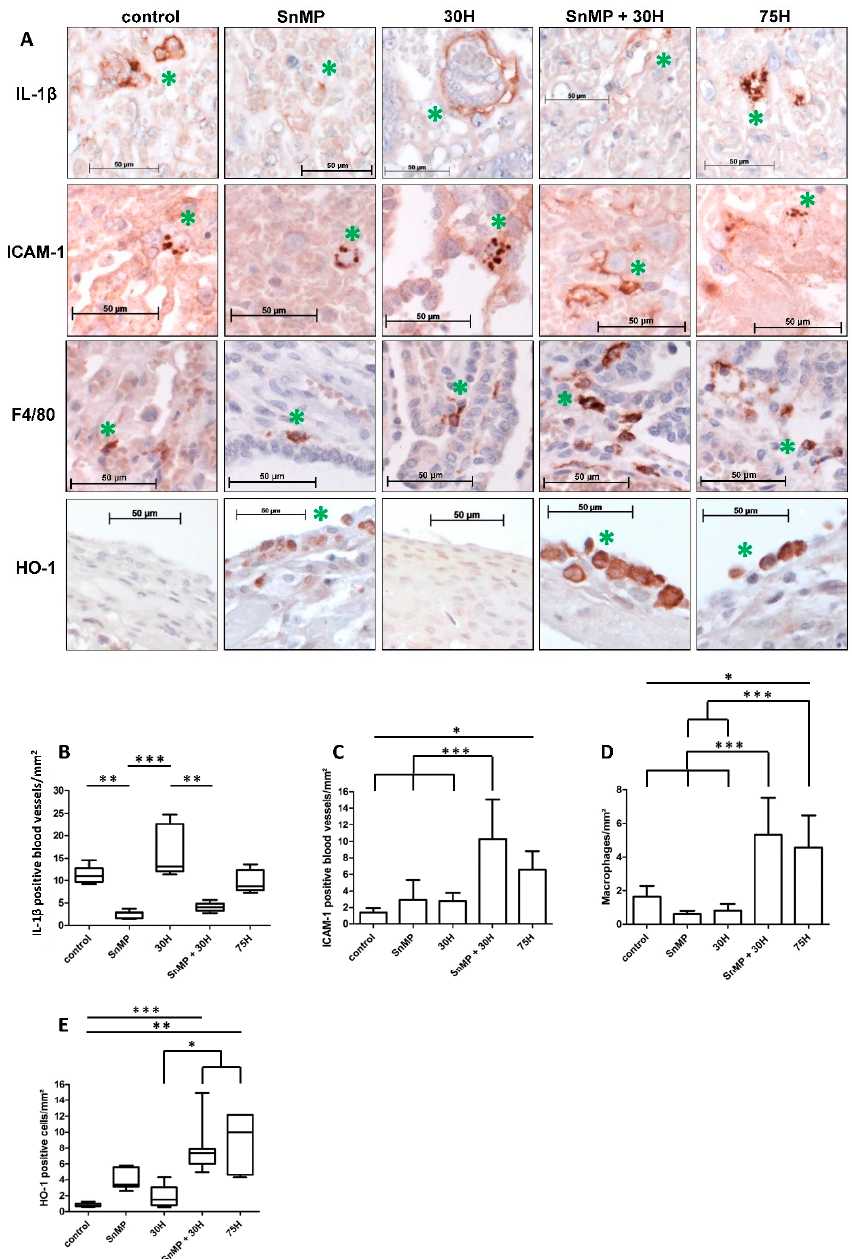
Figure 4. Quantification of IL-1 β , ICAM-1, F4/80 and HO-1 immunoreactivity in placenta. ( A ) Placental sections stained for immunoreactivity of IL-1 β , ICAM-1, F4/80 and HO-1. Representative IL-1 β , ICAM-1, F4/80 and HO-1 immunostaining in placenta from the control and experimental groups. Green asterisk indicates IL-1 β positive blood vessel, ICAM-1 positive blood vessel, F4/80 positive macrophage and HO-1 positive cell, respectively. ( B ) Box-and-whisker plot with 10–90 percentiles of quantitative assessment of the IL-1 β positive blood vessels/mm 2 compared for the different heme and/or SnMP administrations. ( C ) Bar chart of ICAM-1 positive blood vessels/mm 2 compared for the different heme and/or SnMP administrations. Data are shown as mean ± SD. ( D ) Bar chart of number of macrophages/mm 2 compared for the different heme and/or SnMP administrations (control n = 6; SnMP n = 7; 30H n = 6; SnMP + 30H n = 7; 75H n = 5). Data are shown as mean ± SD. ( E ) Box-and-whisker plot with 10–90 percentiles of quantitative assessment of the HO-1 positive cells/mm 2 compared for the different heme and/or SnMP administrations. Quantification of IL-1 β , ICAM-1, F4/80 and HO-1 immunoreactivity in placenta (Control n = 6; SnMP n = 7; 30H n = 6; SnMP + 30H n = 7; 75H n = 5). * p < 0.05, ** p < 0.01, *** p < 0.001. A minimum of five sections from a minimum five placentas per group was assayed.